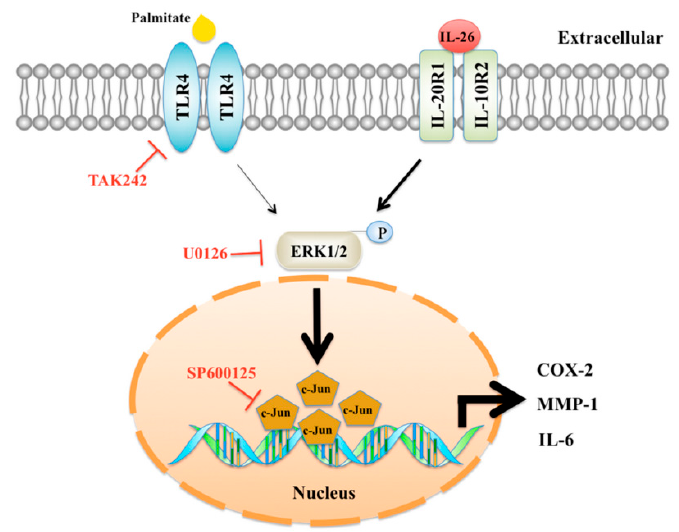
Figure 6 . Schematic illustration of signaling pathways underlying the synergy between palmitate and IL-26 for inflammatory mediators. Activation of the synergistic pathways was induced by palmitate and IL-26 via the TLR4-ERK1/2-c-Jun pathway. TAK242 and U0126 inhibited TLR4 internalization and suppressed the synergistic effect of palmitate and IL-26.